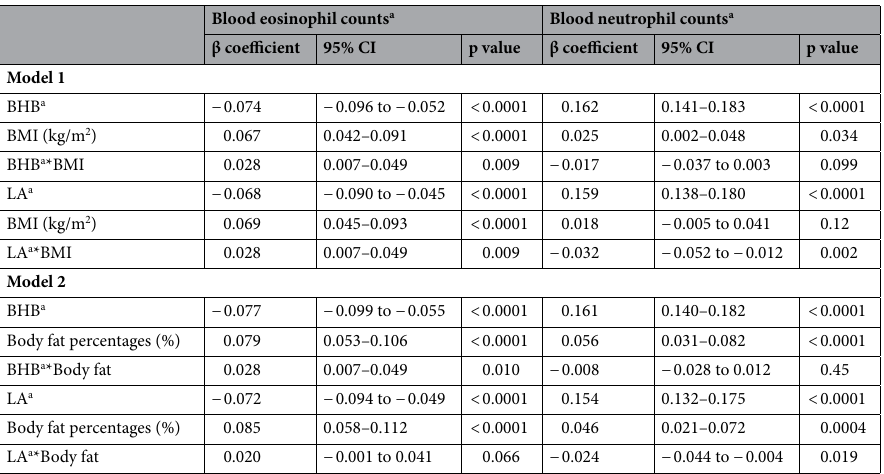
Table 2. Multivariate analysis for associations between serum fatty acid-related metabolites and blood eosinophil counts or neutrophil counts. BHB β-hydroxybutyric acid, LA linoleic acid, BMI body mass index, β coefficient standardized partial regression coefficient, CI confidence interval. a Log-transformed. Multivariate analysis for blood eosinophil counts were adjusted by age, sex, smoking history, elapsed time after a meal, medication for dyslipidemia, serum HDL cholesterol, serum triglycerides, serum total IgE and high-sensitivity CRP. Multivariate analysis for blood neutrophil counts were adjusted by age, sex, smoking history, elapsed time after a meal, medication for dyslipidemia, serum HDL cholesterol, serum triglycerides and high-sensitivity CRP.